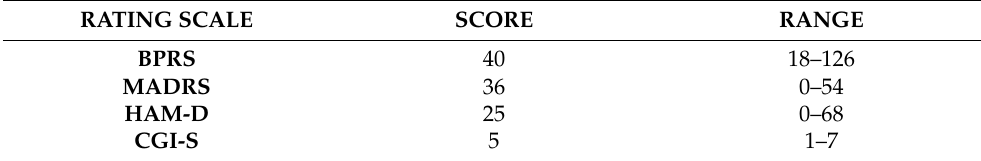
Table 6. Psychometric assessment at first consultation.